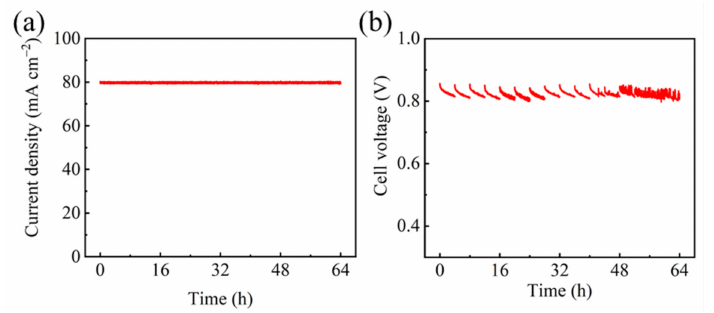
Figure 1. ( a ) Current density versus time and ( b ) cell voltage variation versus time under the current density of 80 mA cm − 2